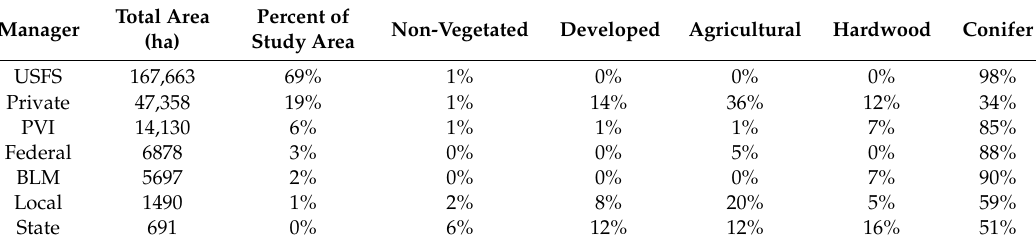
Table 1. Major land manager groups in the Clackamas Basin and associated land cover. Rows